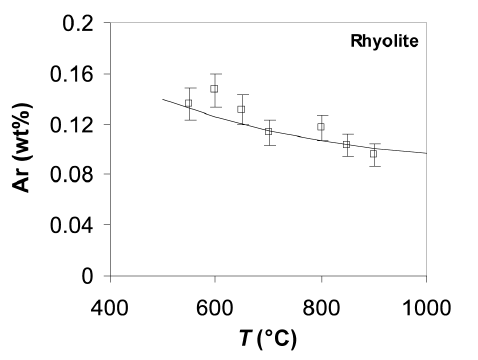
Fig. 11. Dissolved Ar in a rhyolite glass at 120-130 MPa as a function of temperature (data from Carroll and Stolper, 1993). Curves were computed by using eq. (3.6) with parameters in table I. Solubility dis- plays a slightly negative relation with the increase of